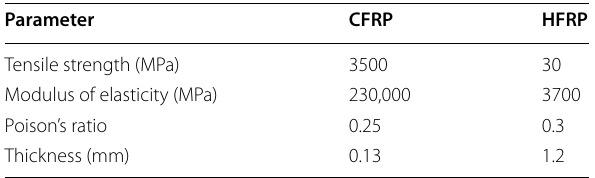
Table 9 Composites material properties.